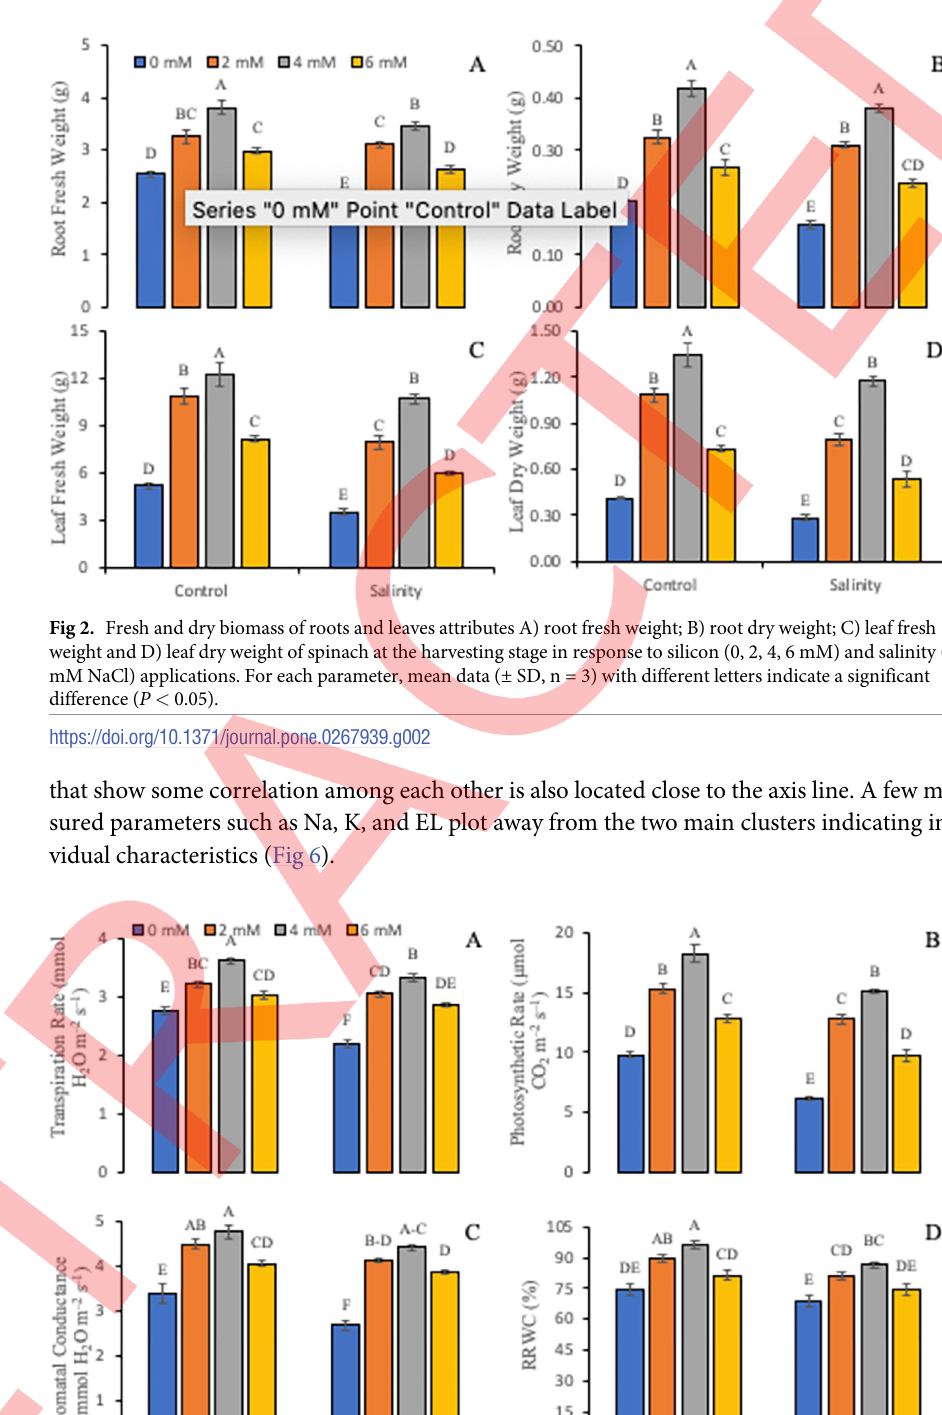
Fig 3. Physiological and water related attribute A) transpiration rate; B) photosynthetic rate; C) stomatal conductance D) relative water contents of spinach at harvesting stage in response to silicon (0, 2, 4, 6 mM) and salinity (150 mM NaCl) applications. For each parameter, mean data ( ± SD, n = 3) with different letters indicate a significant difference ( P <